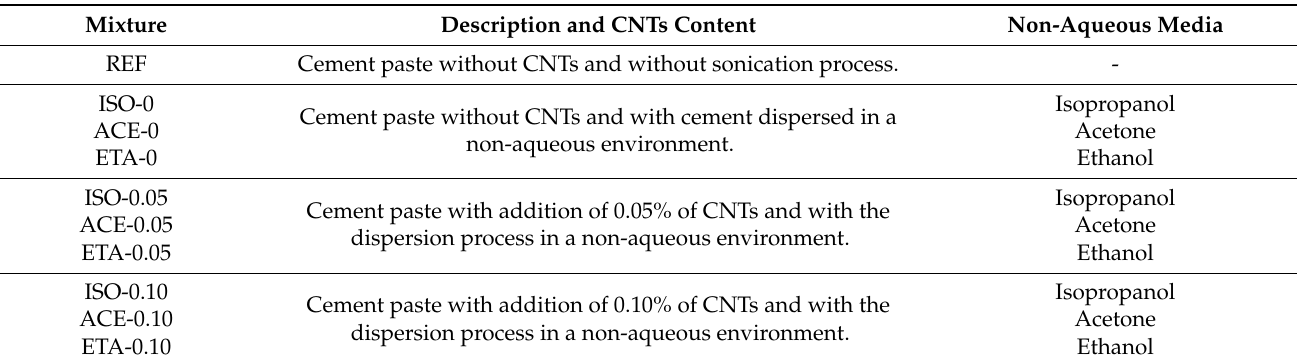
Table 1. Cement paste